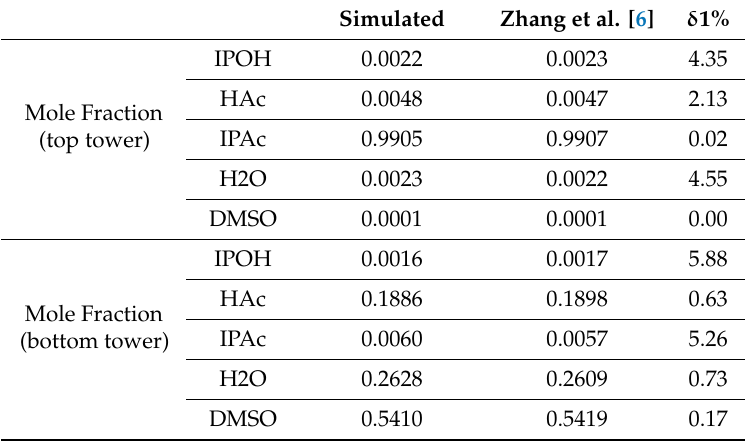
Table 3. Comparison of product composition of Example